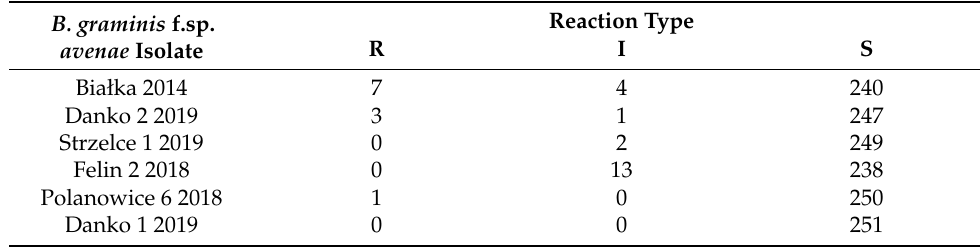
Table 2. Number of A. fatua accessions resistant (R), intermediate resistant (I) and susceptible (S) to six B. graminis f.sp. avenae isolates.